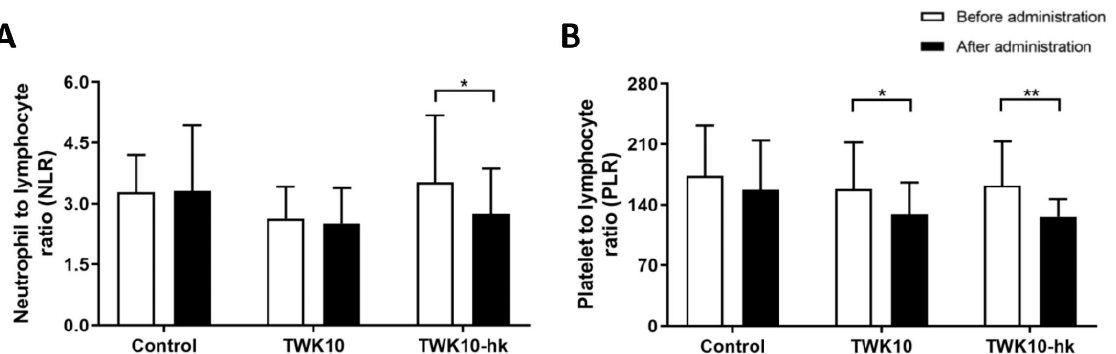
Figure 2. Effects of TWK10 on pro-inflammatory indicators after exercise challenge. Blood samples were collected and analyzed at 120 min after fixed intensity and period exercise challenges. ( A ) Neutrophil to lymphocyte ratio (NLR), and ( B ) platelet to lymphocyte ratio (PLR) were examined. Data are presented as mean ± SD. The significance of differences among groups were analyzed by two-way repeated-measures ANOVA with Tukey post-hoc test. Differences before and after administration were analyzed by two-way repeated-measures ANOVA with Bonferroni post-hoc test. * P < 0.05, ** P < 0.01.